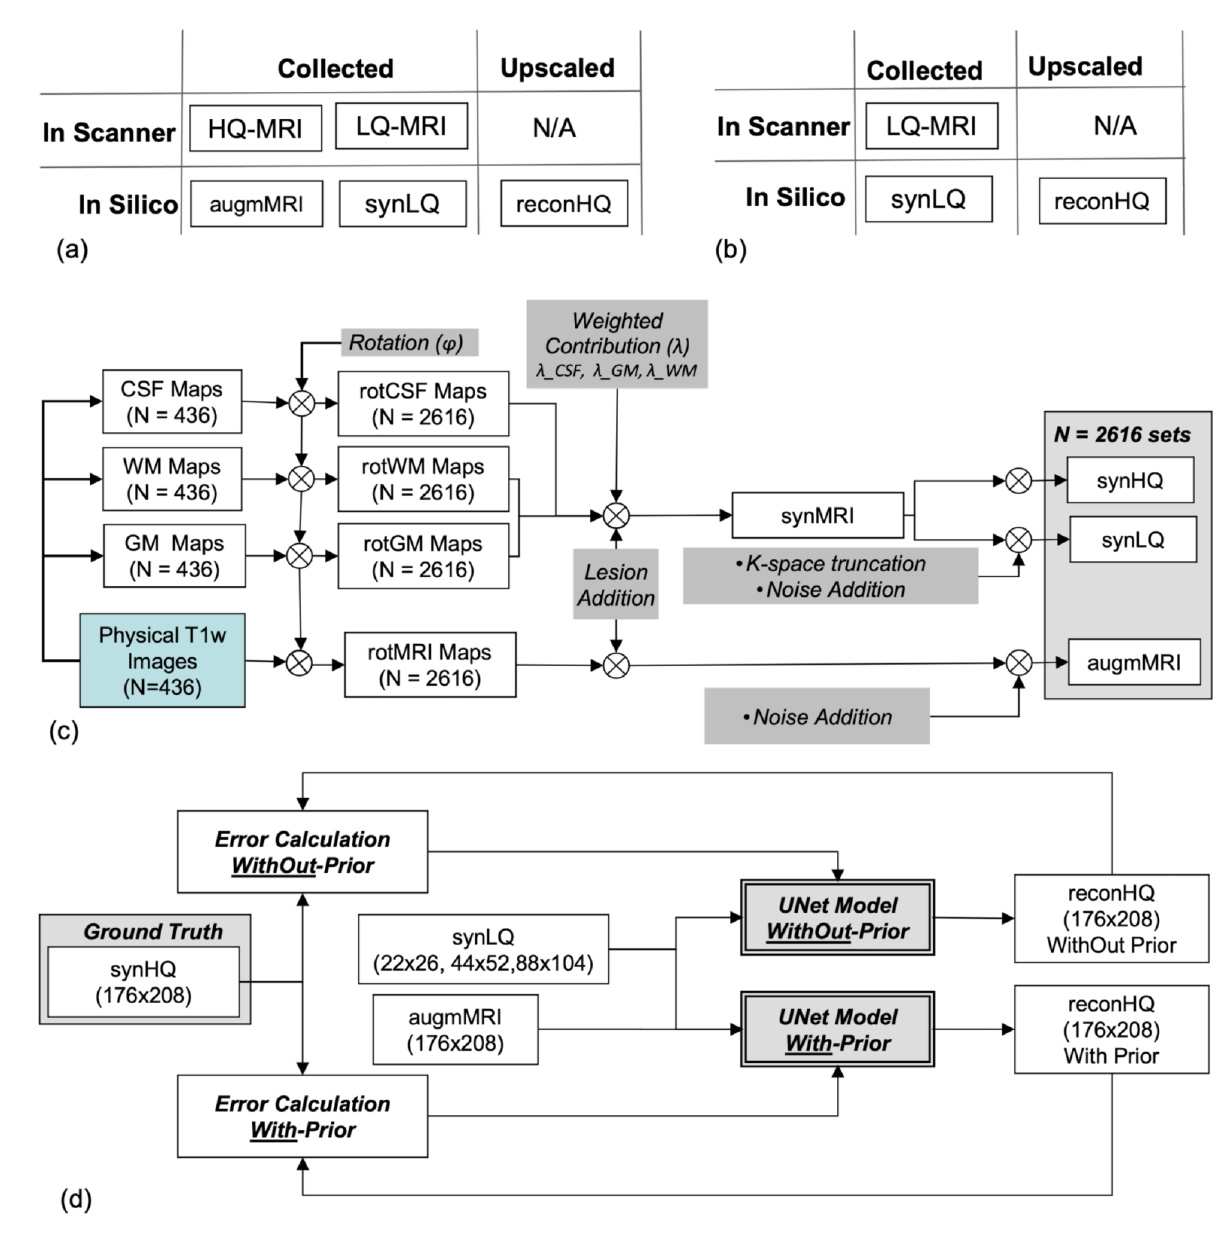
Figure 1. ( a , b ) Illustrations of the two paradigms With-Prior ( a ) and WithOut-Prior ( b ) (i.e., same- subject complementary high resolution images collected at the same location), showing the type of data collected on the scanner and generated in silico. ( c ) Flowchart of the processes employed in the generation of 2616 data sets that included high quality synthetic (synHQ), low quality synthetic (synLQ), and augmented physically collected T1-weighted (augmMRI) images. ( d ) Flowchart of the UNet training to upscale the synLQ to synHQ, for the two paradigms of With- and WithOut-Prior; in the first case, the augmMRI served as the high quality complementary prior.